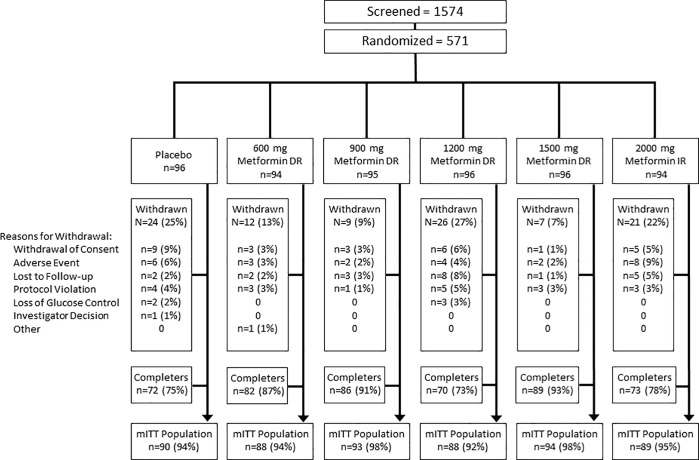
Study flow diagram.